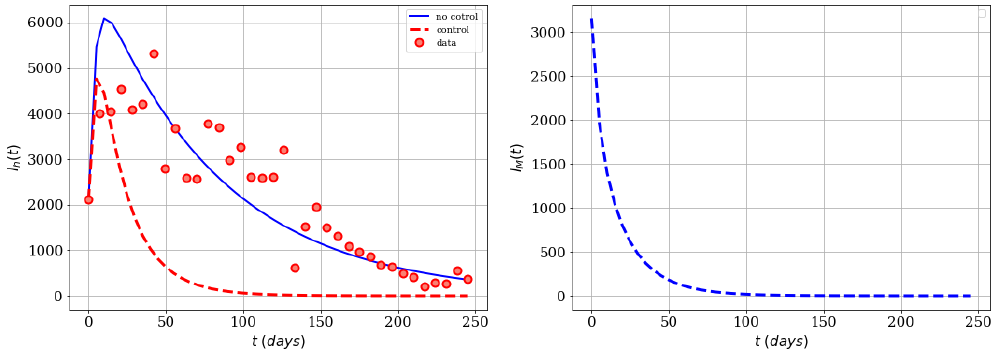
Figure 7. Numerical simulation using both infected subpopulations in the functional ( κ 1 = 0.09, κ 2 = 0.01, u 1 max = 0.5), and both time-dependent controls u 1 and u 2